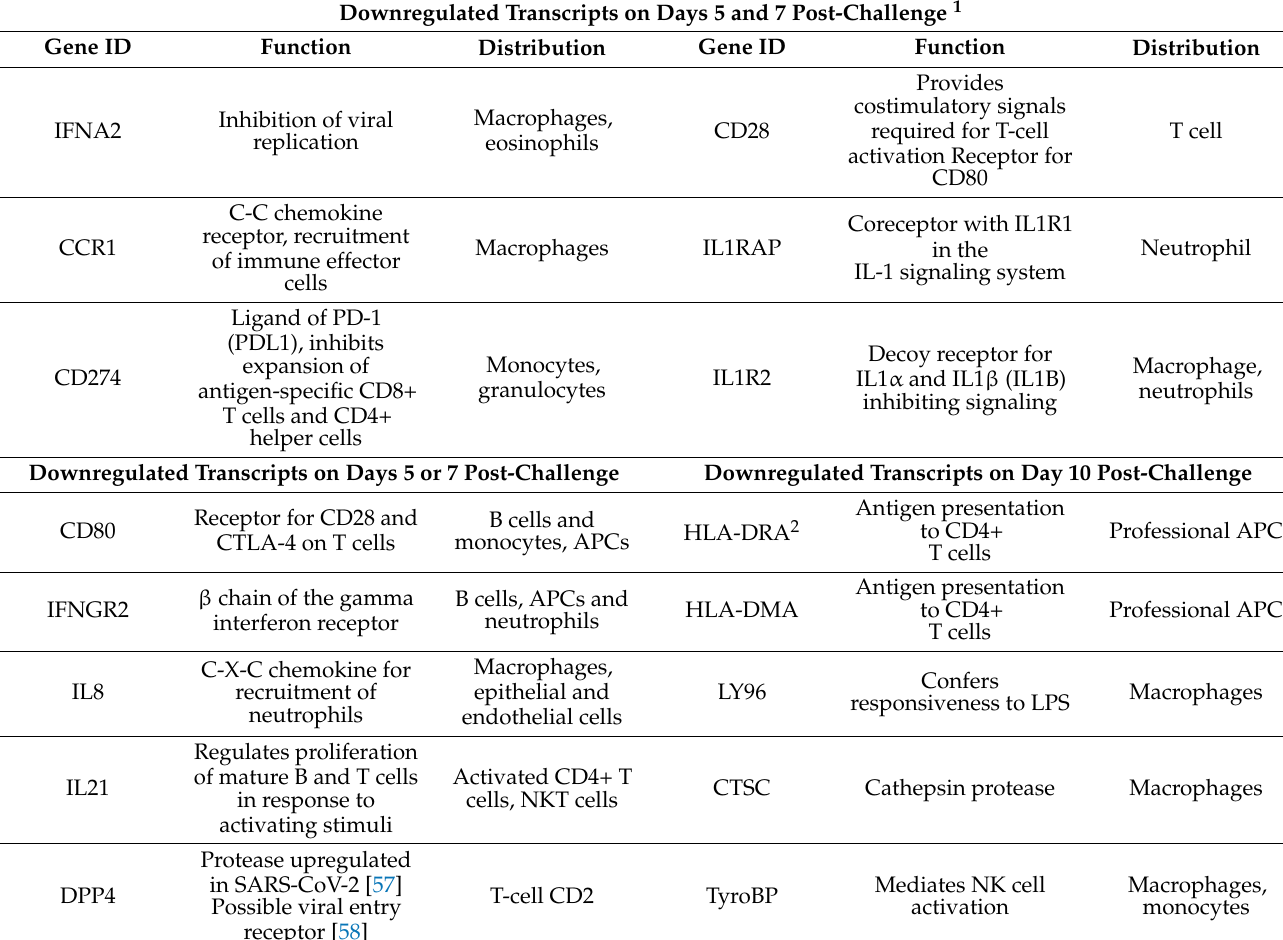
Table 2. Differentially regulated genes in BAL cells obtained from SARS-CoV-2-challenged vaccinated versus con- trol